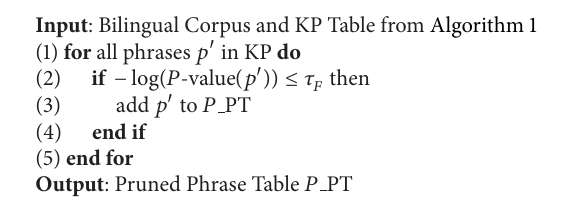
Algorithm 3: Algorithm for key phrase